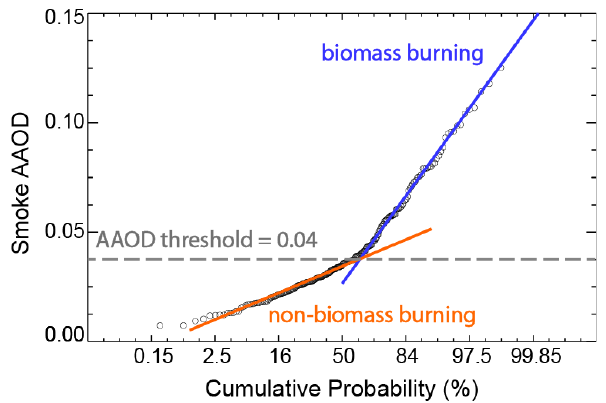
Fig. 2. Cumulative probability distribution of OMI smoke AAOD 8- day average values at 1 × 1 ◦ resolution over southern Africa (south of 5 ◦ S) for 2005–2009. The x-axis is a probability scale such that a normal distribution would plot as a straight line. This allows us to separate biomass burning from non-biomass burning conditions by plotting separate regression lines fitted to the bottom and top quantiles of the data. Intersection of these regression lines defines a smoke AAOD threshold for diagnosing biomass burning conditions and we remove the corresponding scenes from the OMI data set. Different AAOD thresholds are used for different regions of Africa as discussed in the